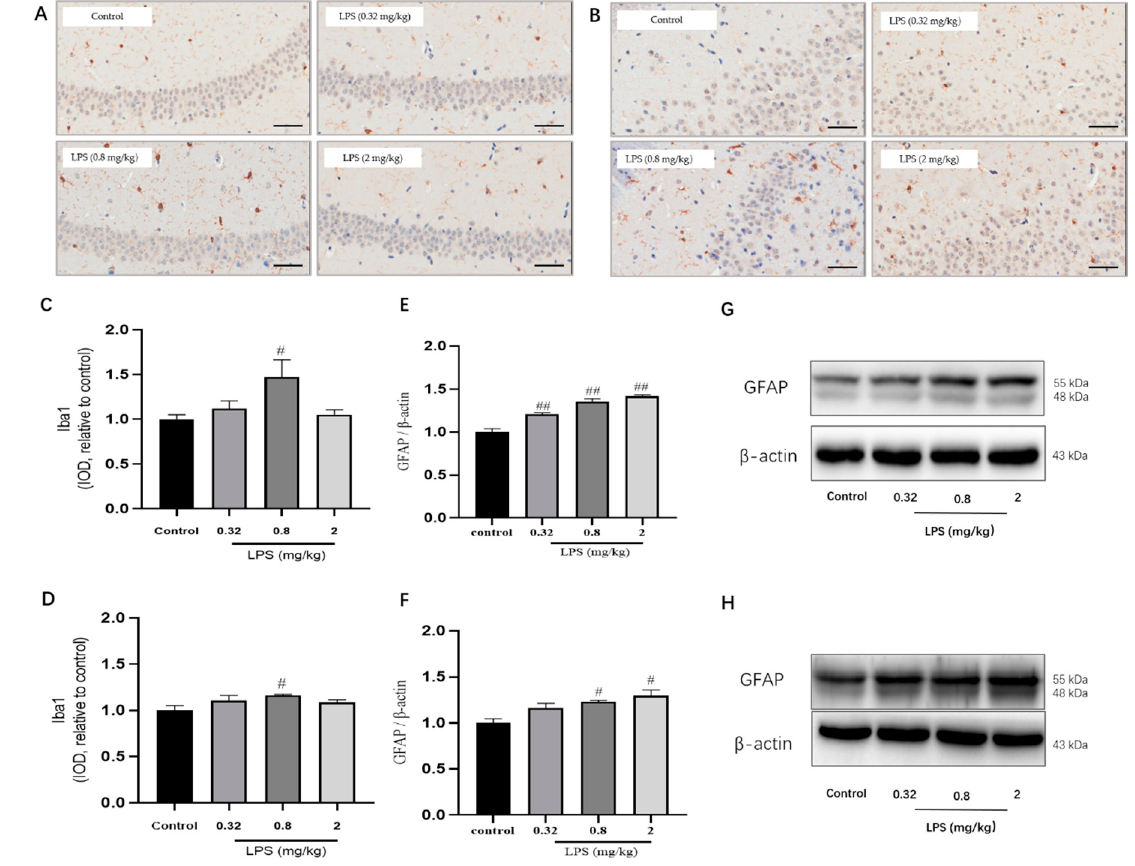
Figure 5. Effects of different doses of LPS (i.p.) on the status of microglia and astrocytes in the brain of mice. Representative micrographs of immunohistochemistry of Iba1 (brown) of microglia in the hippocampus ( A ) and prefrontal cortex ( B ). The scale bar represents 50 μ m in these images. Quantification of IOD of microglia in the hippocampus ( C ) and prefrontal cortex ( D ) ( n = 3 for each group). Representative protein bands of GFAP, a marker for astrocytes, in the hippocampus ( E , G ) and cortex ( F , H ). Graphs were plotted as mean ± SEM. Data were analyzed by the Mann–Whitney U test. # p < 0.05 compared to the control group, ## p < 0.01 compared to the control group.